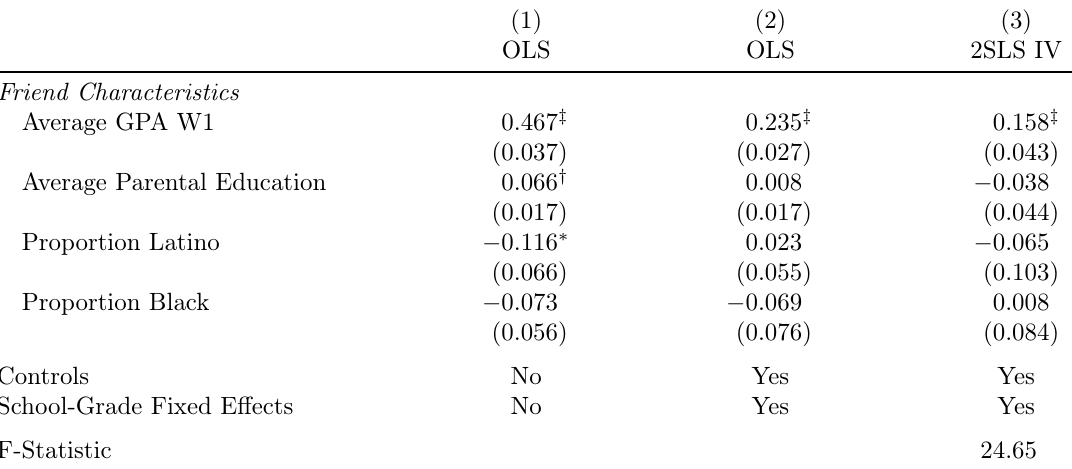
Table 2: OLS and IV regression estimates predicting self-reported GPA, Add